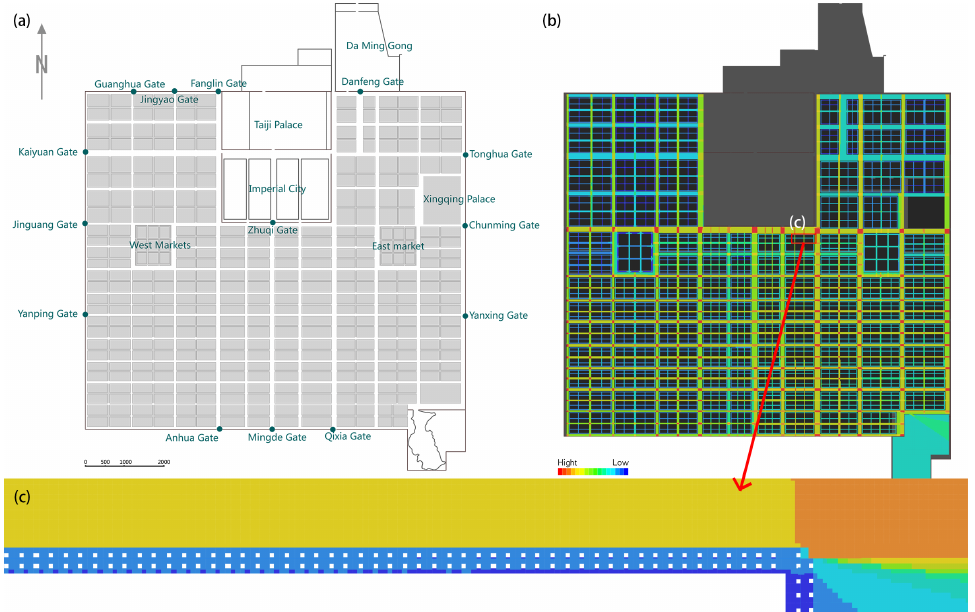
Figure 14. ( a ) Chang’an City plan, ( b ) City-wide visibility graph analysis, ( c ) Enlarged view of the results of the city-wide Visibility Graph Analysis around the trees on both sides of